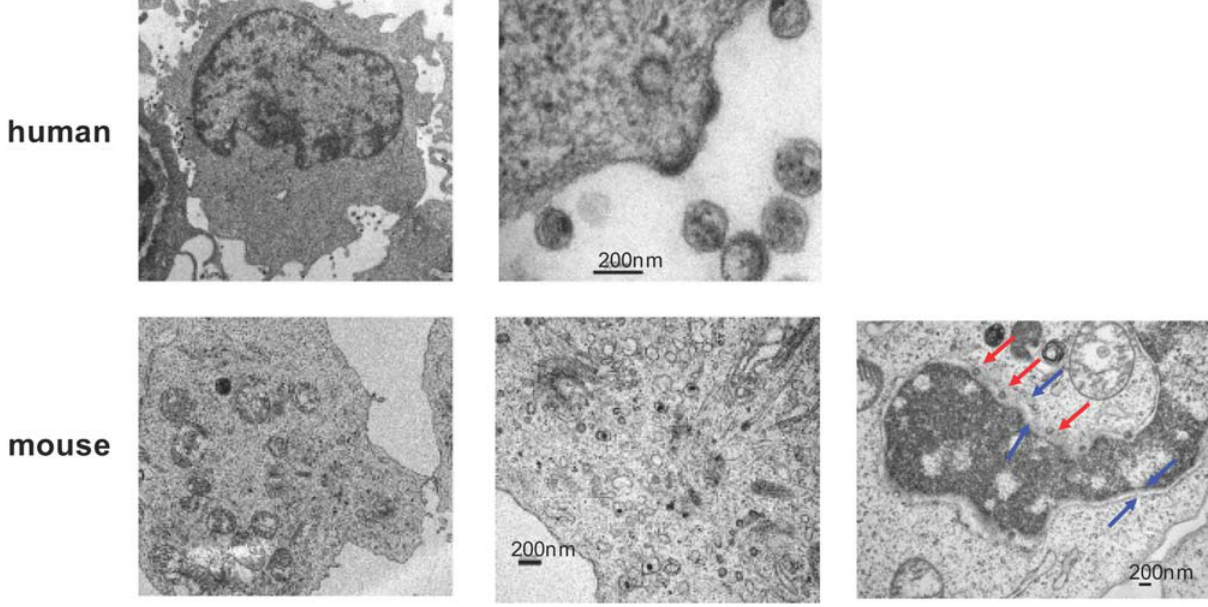
Figure 9. Defective virus budding in HIV infected mouse T cells. Electron microscopy of infected human (upper panel) and mouse (lower panel) T cells. On the left, low magnification of infected cells; in the middle, higher magnification of infected cells; on the right (for mouse T cells), aberrant budding of VLP into nuclear membranes is shown. Red arrows indicate assembling viral particles, while blue arrows indicate inner and outer nuclear membranes.